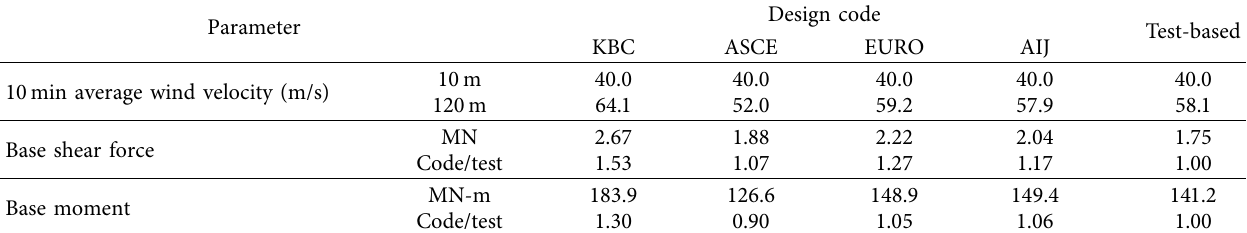
Table 4: Base shear forces and moments at basic wind velocity of 40 m/s.